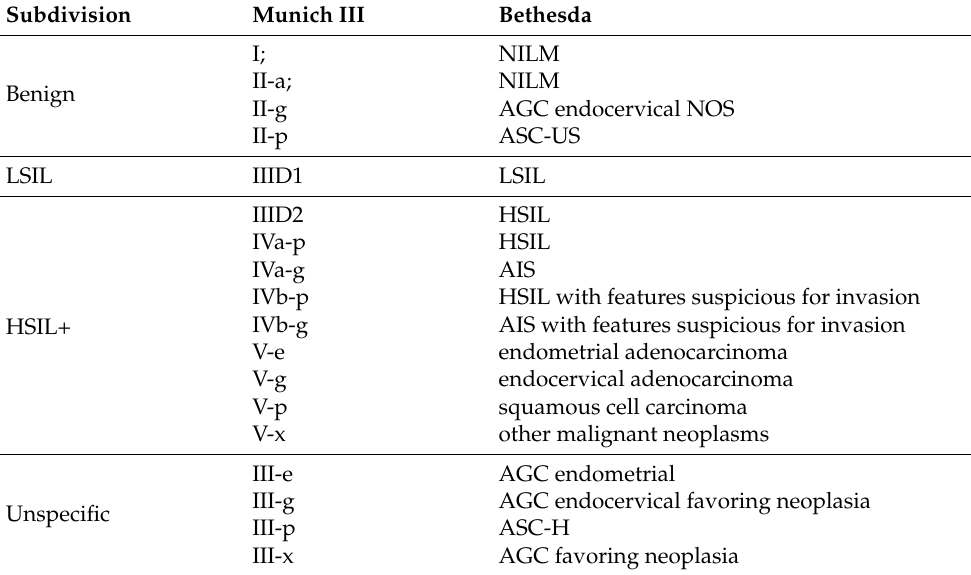
Table 1. Subdivisions of PAP-Groups for statistical analysis (NILM:Negative for intraepithelial lesions or malignancy; AGC atypical glandular cells; NOS: not otherwise specified; ASC-US: Atypical squamous cells of undetermined significance; HSIL: High-grade squamous intraepithelial lesion; AIS: Adenocarcinoma in situ; ASC-H: atypical glandular cells of undetermined significance